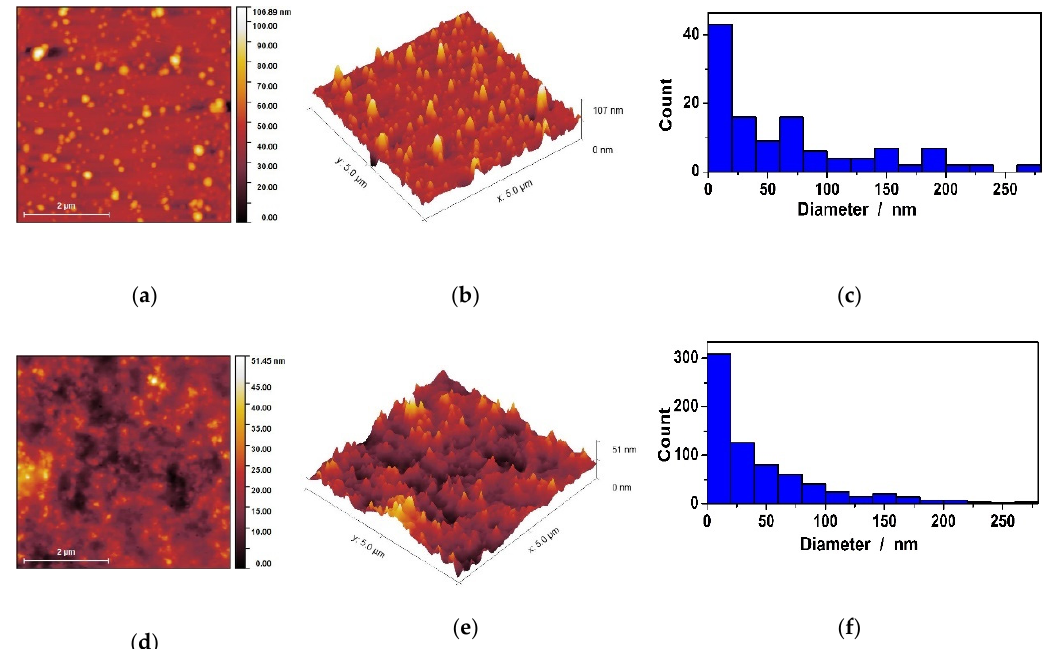
Figure 8. Morphological characterization of uncoated AgNPs. MNT-nAg ( a , b and c ), and AMT-nAg ( d , e and f ): topography ( a , d ); three-dimensional ( b , e ) and histogram distribution of nanoparticles heights ( c , f ) Atomic Force Microscopy (AFM) images. Coatings 2020 , 10 , x FOR PEER REVIEW 14 of 24